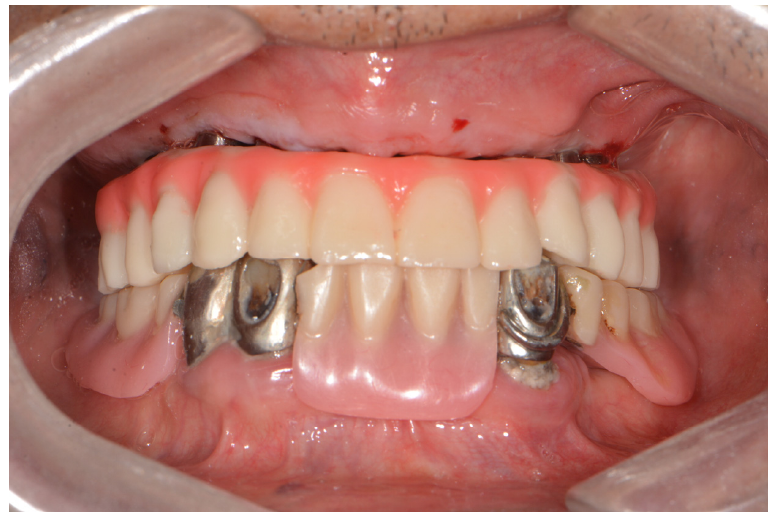
Figure 8. Definitive restoration fabricated by CAD/CAM based on direct digital scans of the interim restorations made with intraoral scanners.